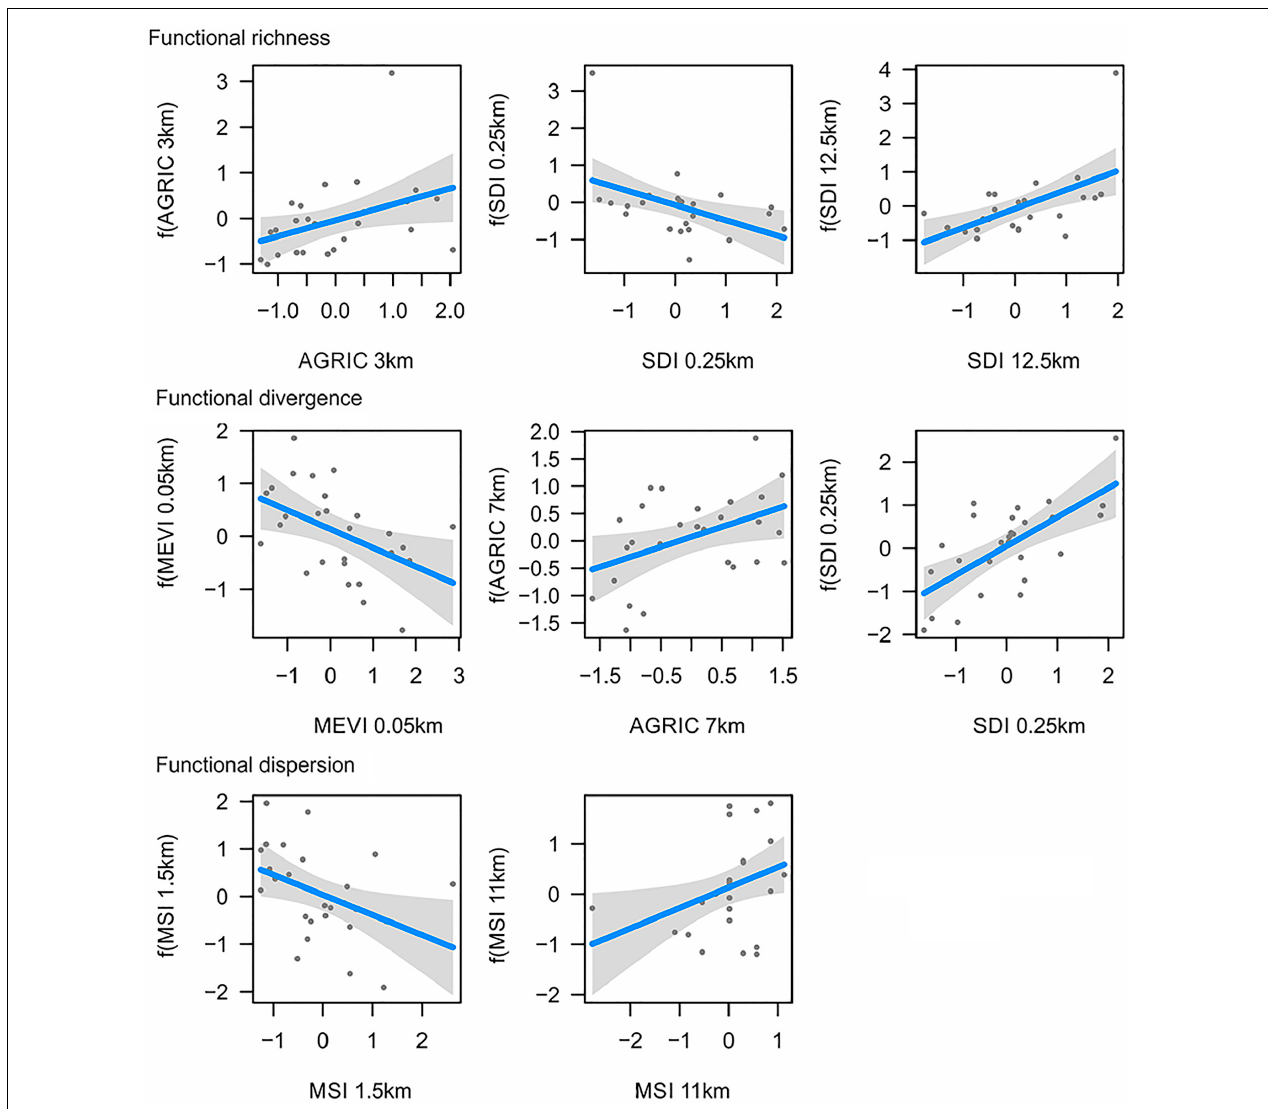
FIGURE 2 | Influence of landscape and local vegetation descriptors on bee functional richness, functional divergence, and functional dispersion in the agricultural region at Mucuge-Ibicoara, Chapada Diamantina, Bahia, Brazil. The numbers in parentheses indicate the best spatial scale for landscape variables. Shaded areas indicate confidence interval at level 95% for the predicted